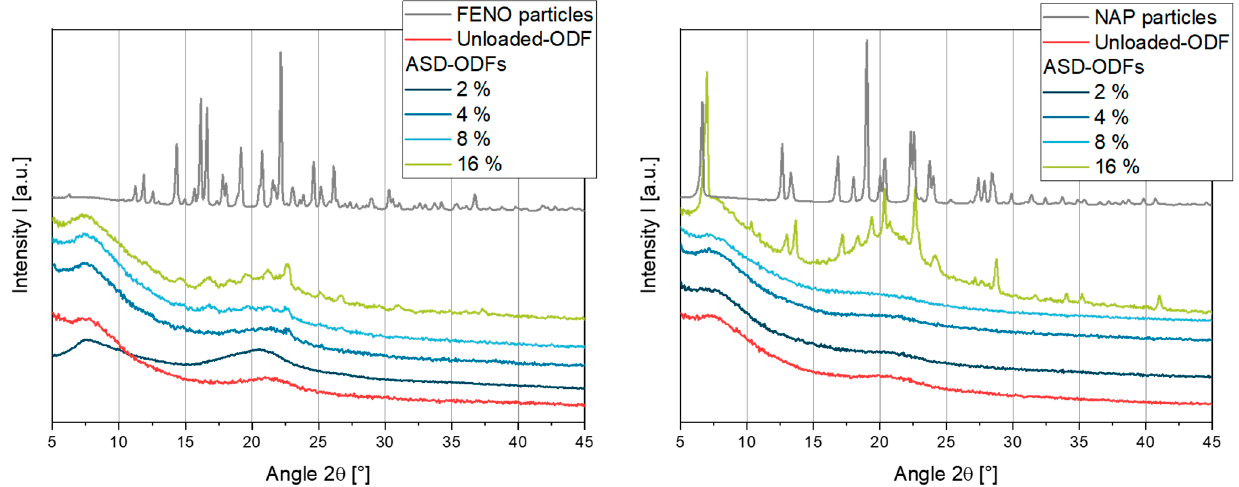
Figure 3. XRD measurements of ASD-ODFs loaded with the two model APIs FENO ( left ) and NAP ( right ).